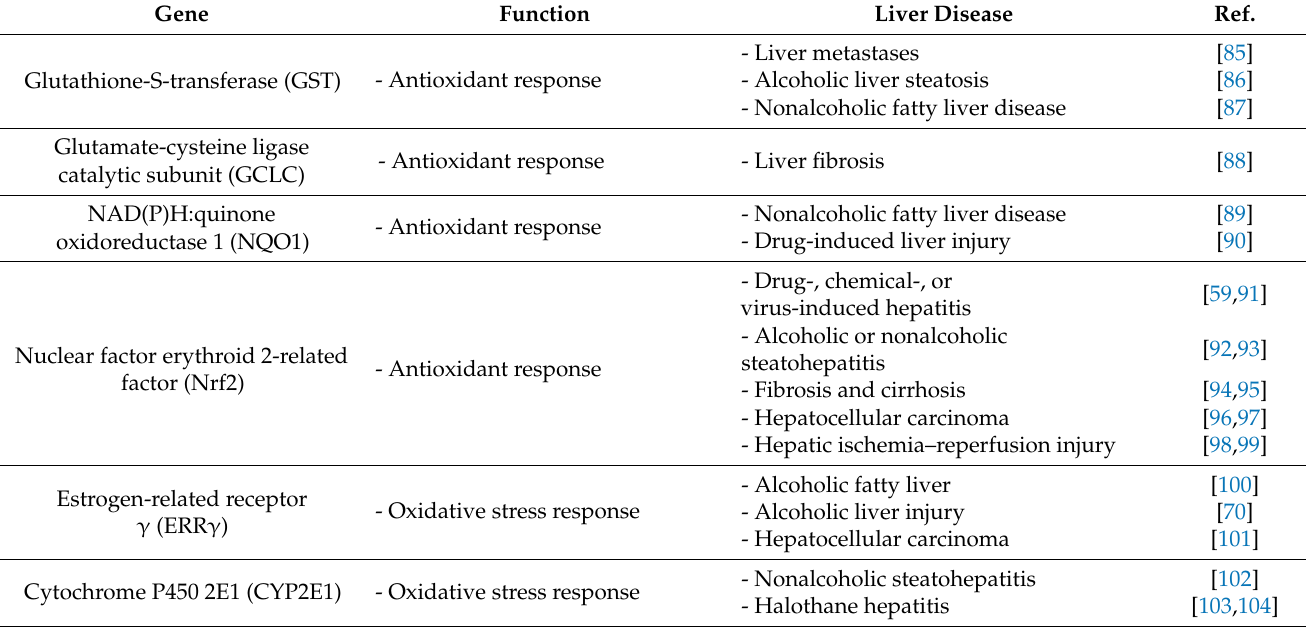
Table 1. List of hepatic oxidative stress responsive gene and its function in preventing liver diseases. Gene Function Liver Disease